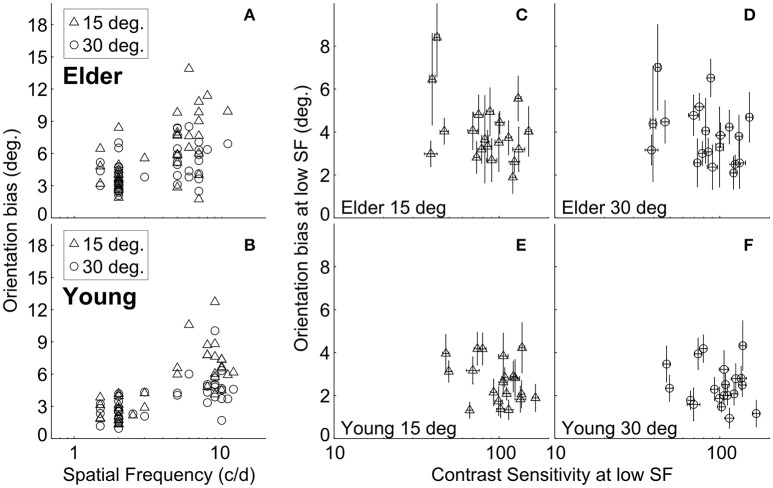
Relation between tilt repulsion, SF and CS at low-SF. Relations between tilt repulsion and SFs under ±15° (triangles) and ±30° (circles) SOs across all measured subjects in older adults (A) and younger (B) groups; Relations between tilt repulsion and CS at low-SF in the elderly group [±15° in (C); ±30° in (D)] and younger (±15° in (E); ±30° in (F)] groups. Error bars are bootstrapped SE.